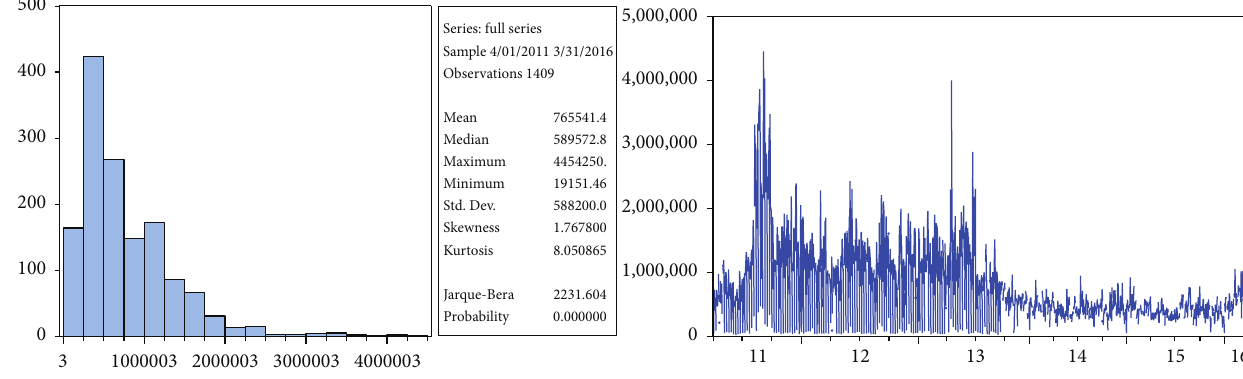
Figure 1: Descriptive statistic of the time series from 2011 to 2016.